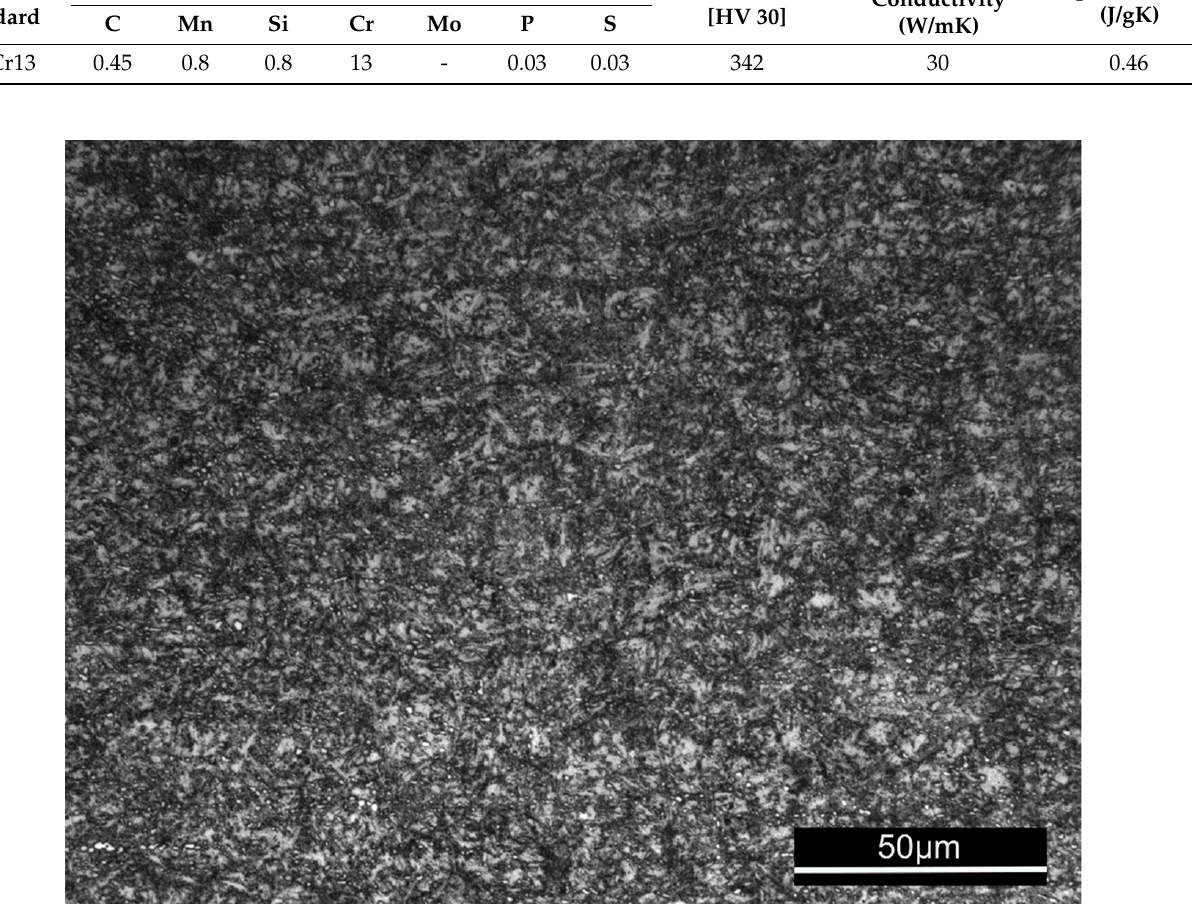
Table 1. Properties of the coatings (WC ‐ CoCr and WC ‐ FeCrAlY). Properties Figure 2. SEM BSE image of the cross ‐ section of the (a) WC ‐ CoCr (b) WC ‐ FeCrAlY coating. Figure 2. SEM BSE image of the cross-section of the ( a ) WC-CoCr and ( b ) WC-FeCrAlY coating. Table 2. The composition and properties of the conventional martensitic stainless steel. Chemical Composition, wt. % European Standard